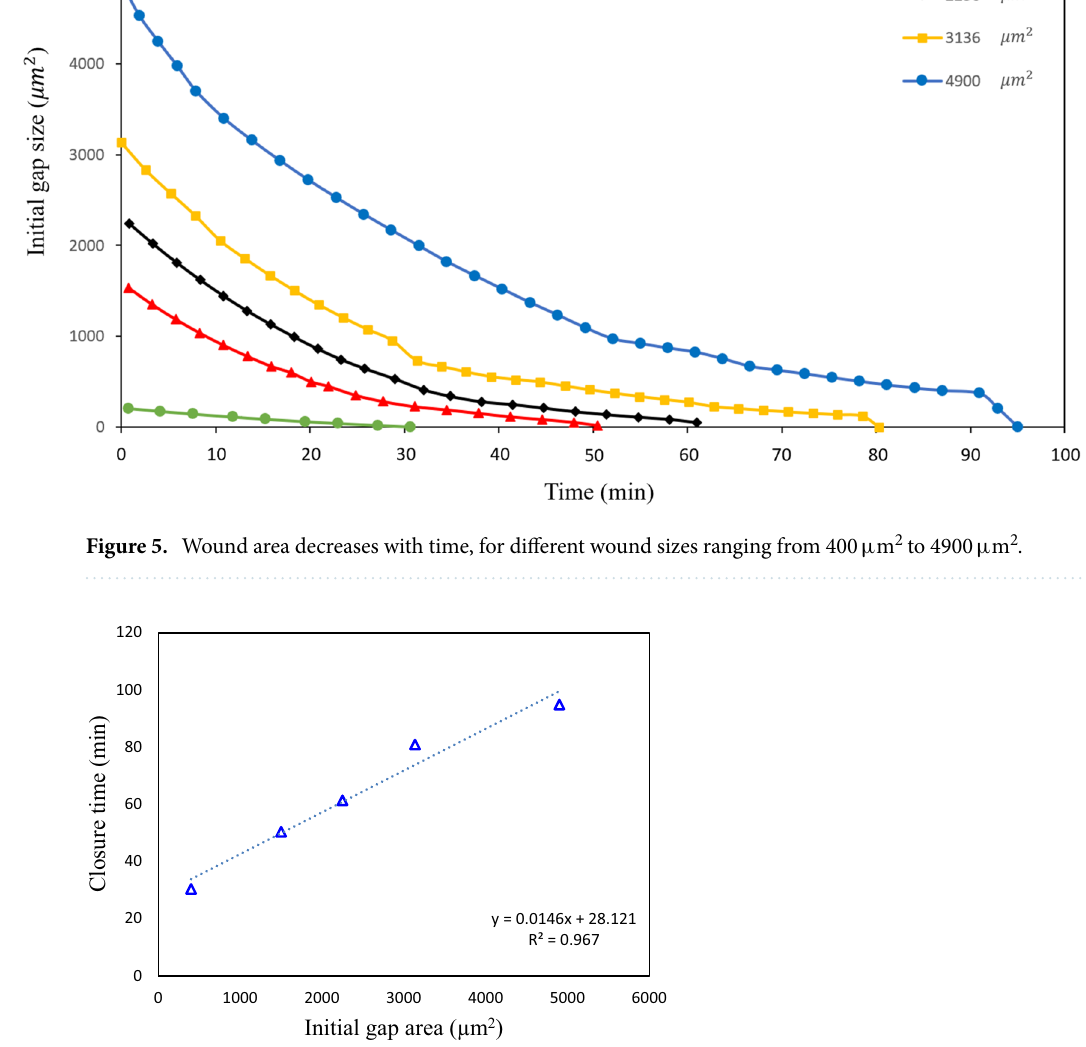
Figure 6. Wound closure time as a function of the initial wound gap area. The linear fitting of simulation data is shown by the dashed